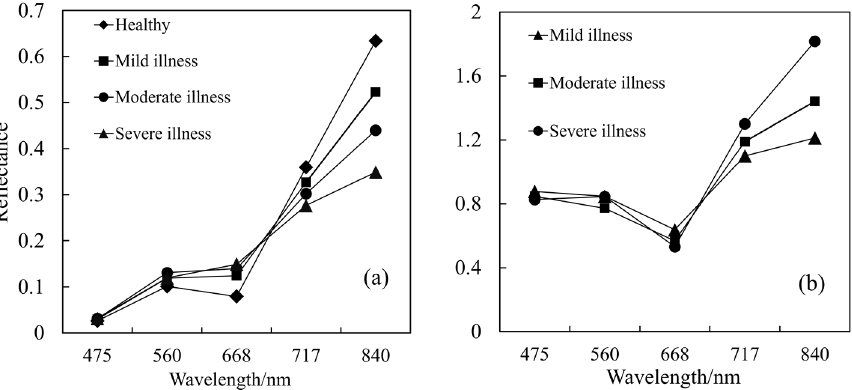
Figure 3. Spectral reflectance curve: ( a ) the spectral curves of wheat with different degrees of disease; ( b ) the ratio of healthy wheat to diseased wheat. Table 3. DI and the coefficient of correlation of spectral parameters.